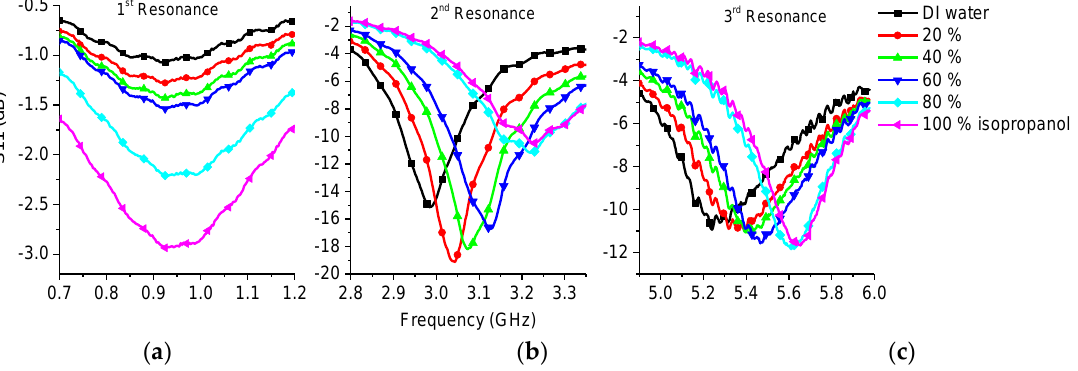
Figure 11. Measurement results of isopropanol-water mixture: ( a ) 1st resonance; ( b ) 2nd resonance; ( c ) 3rd resonance.